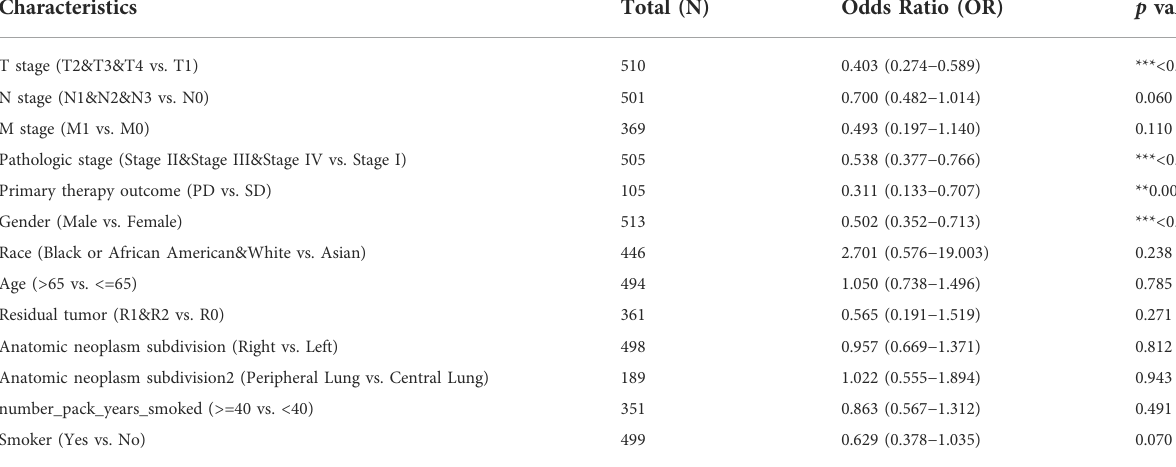
TABLE 1 GNG7 expression association with clinical pathological characteristics (logistic regression).